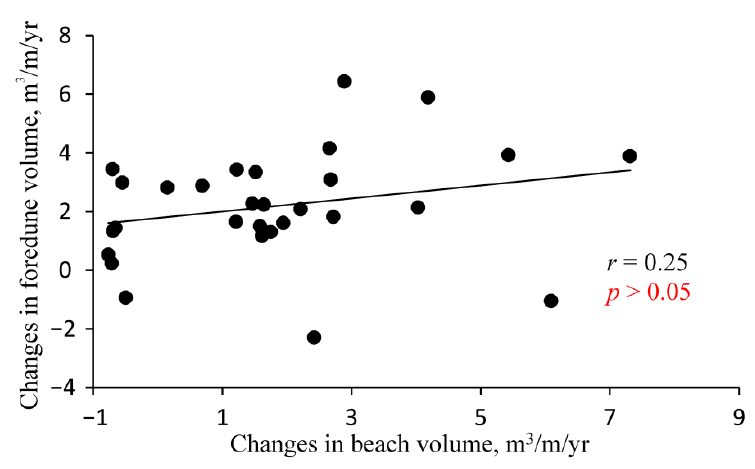
Figure 9. Correlation between changes in the beach and foredune sand volume.